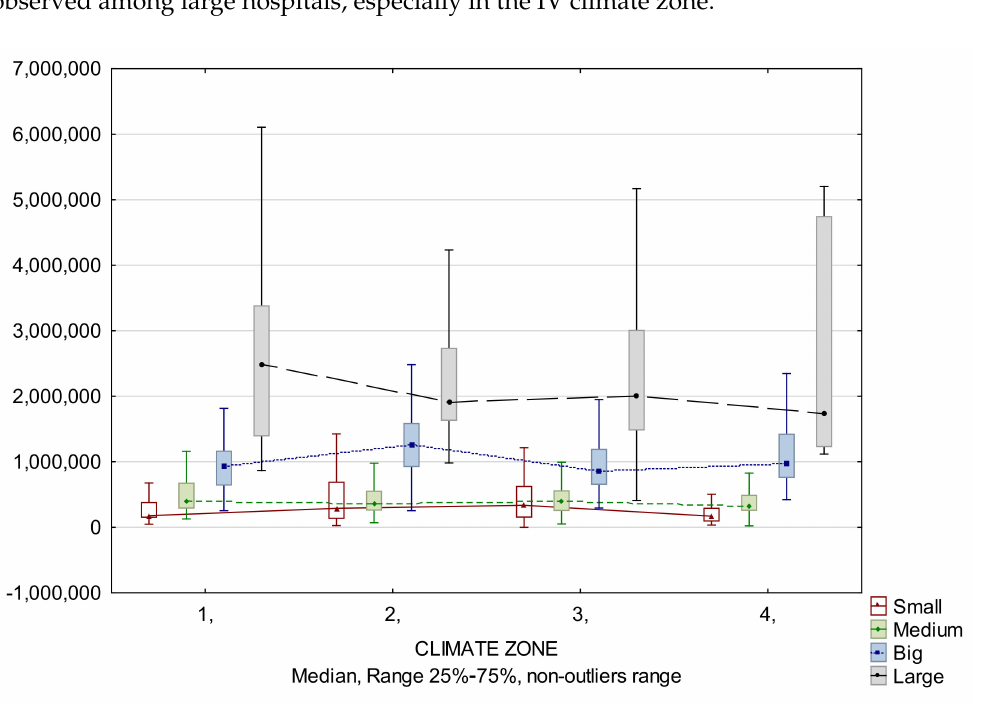
Figure 7. EEC by the size of the hospitals relative to the climate zones in